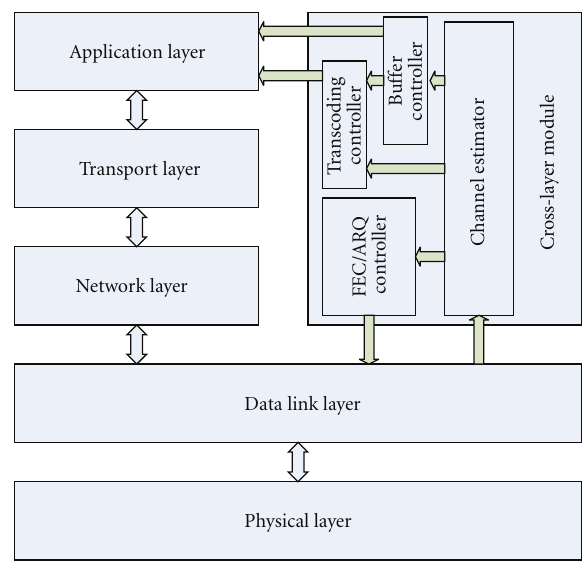
Figure 1: Augmented TCP/IP stack with the proposed cross-layer module